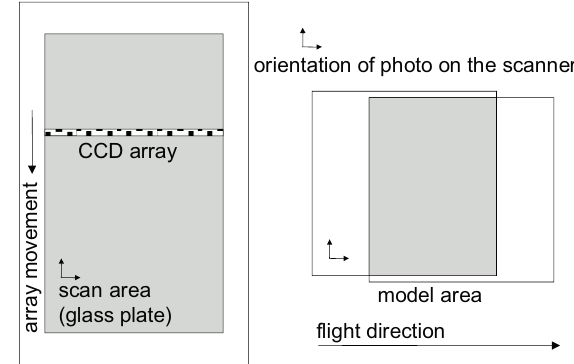
Fig. 2. Orientation of aerial photographs on the flatbed